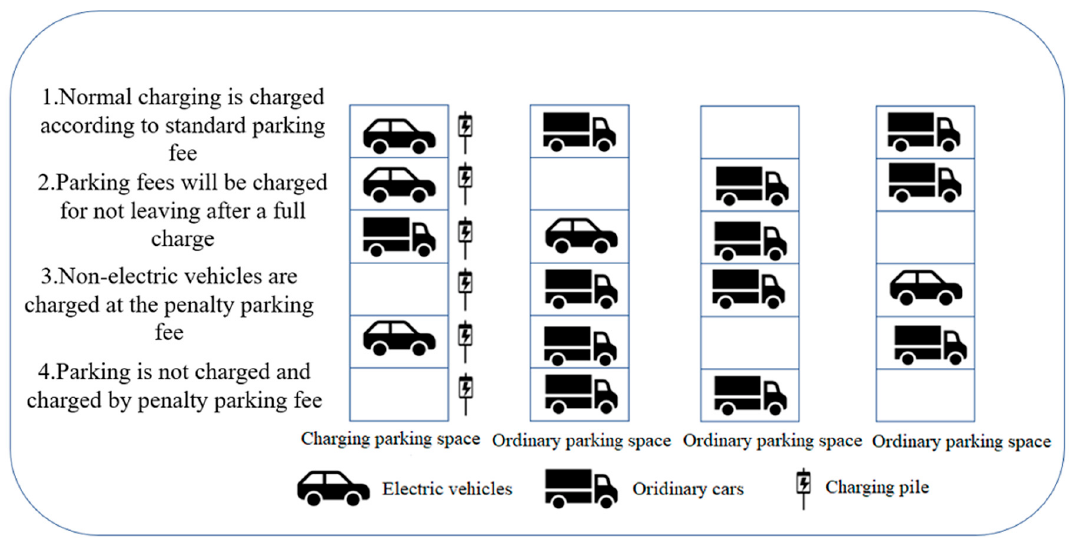
Figure 2. Charging scenario diagram of a parking lot.